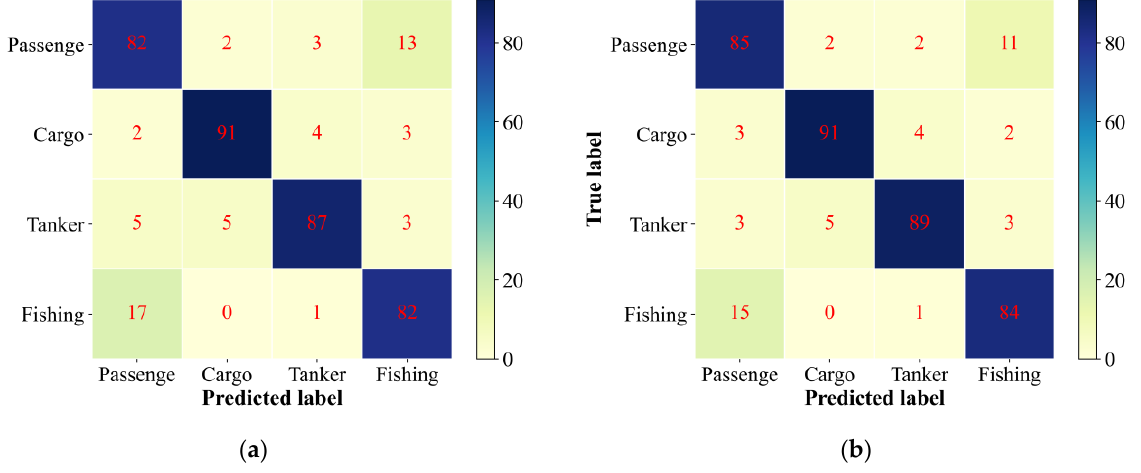
Figure 9. Ship classification accuracy of different methods on the AIS test set.